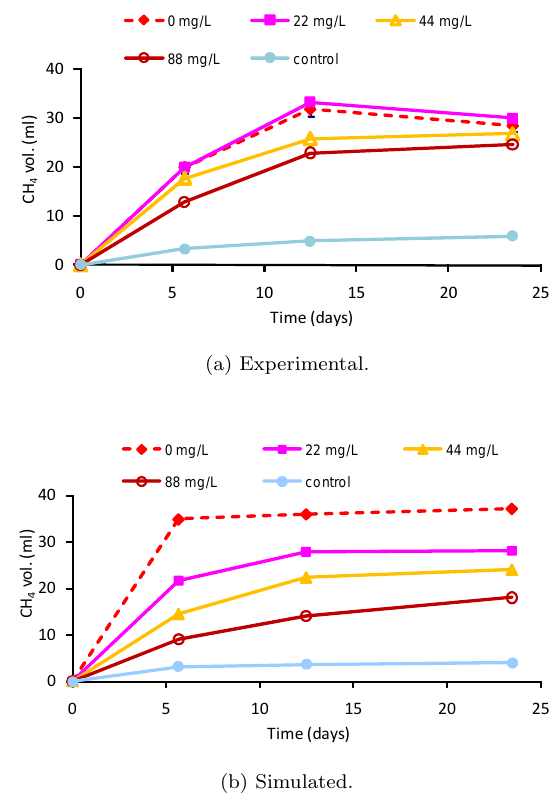
Figure 2: Relative placement of methane generation curves under different oxygen loading condi- tions according to the experimental data and the simulation predictions. According to the experimental data (Fig. 2a), 22 mg / L oxygen load only induce a minor (not